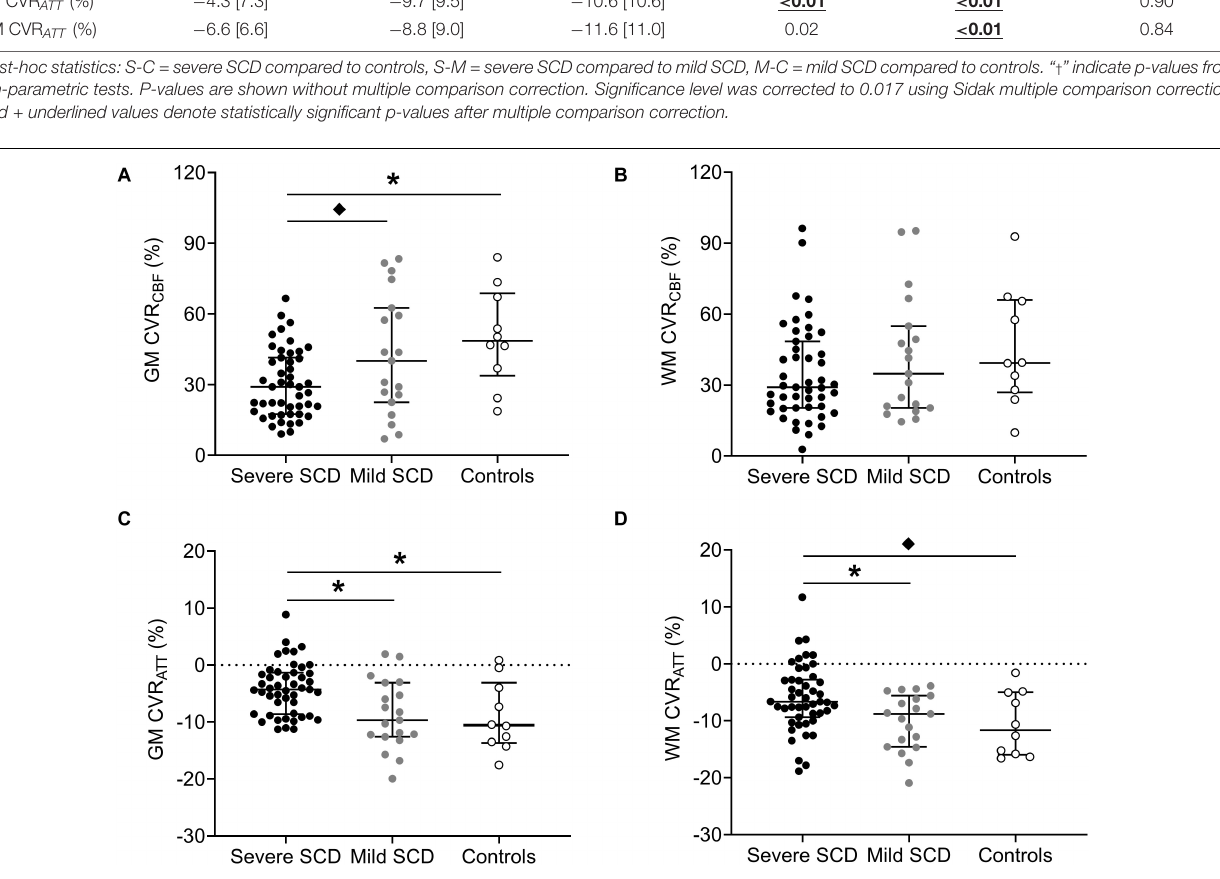
FIGURE 2 | Dot plots with median and interquartile ranges showing CVR CBF and CVR ATT in GM (A,C) and WM (B,D) in patients with severe- and mild SCD and healthy controls. Statistically significant differences, after multiple comparison correction, are indicated by lines with asterisks ( p < 0.017). “ (cid:169) ” denote statistically significant differences that did not remain after multiple comparison